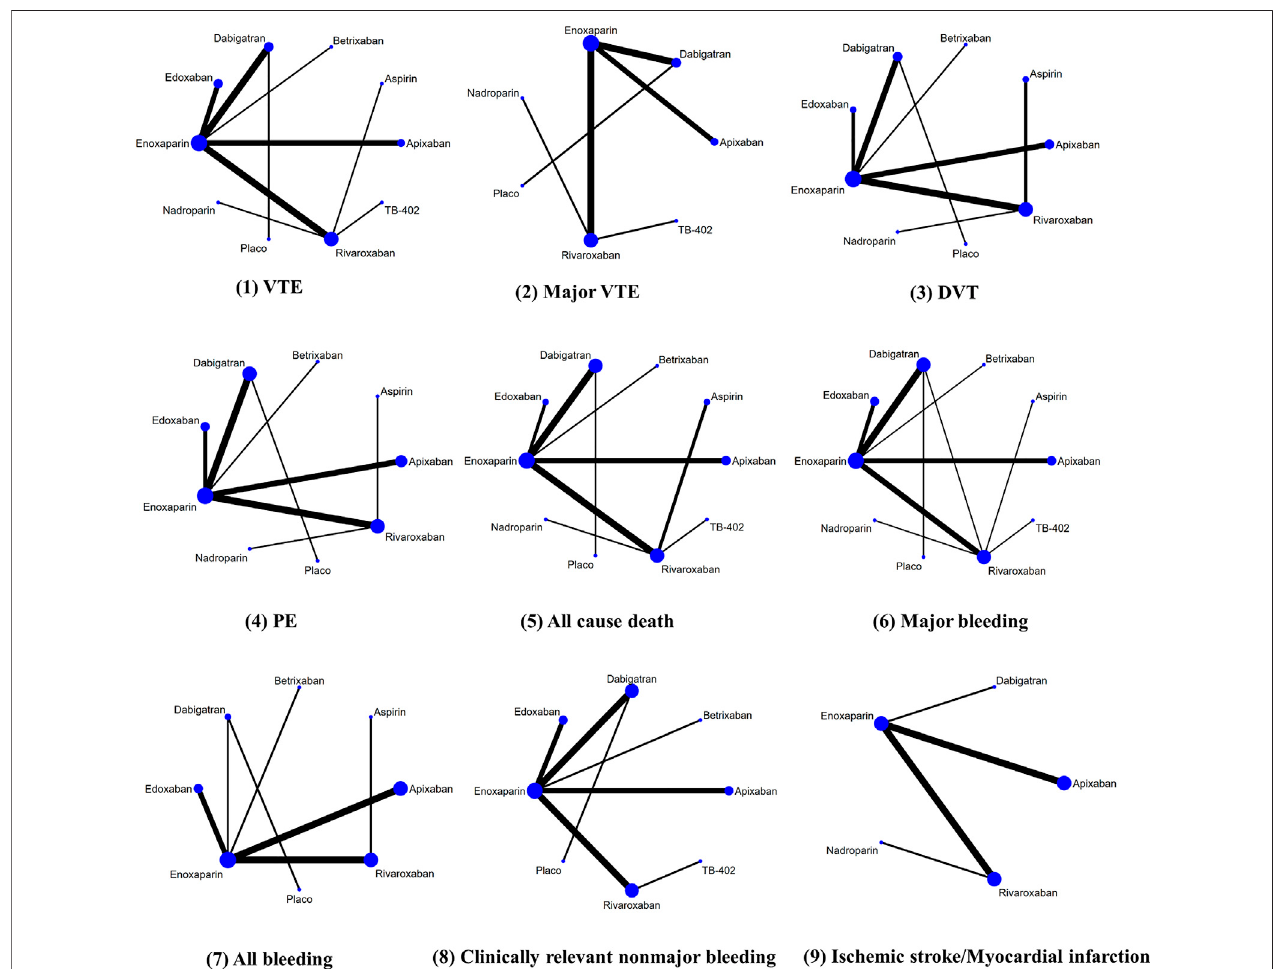
FIGURE 3 | Network diagrams of primary and secondary outcomes in THA and TKA